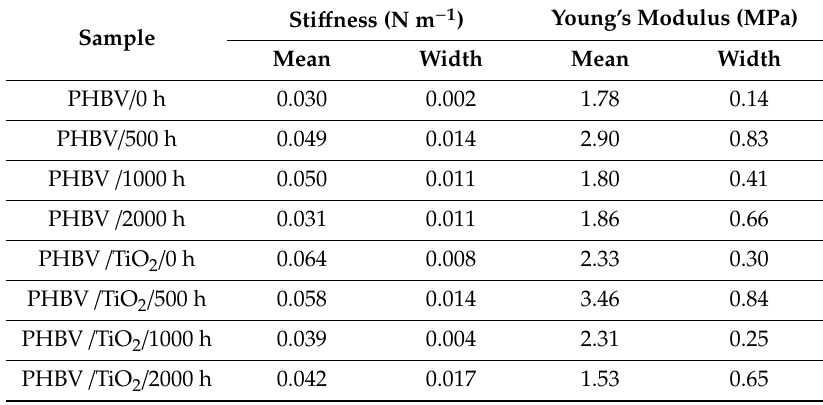
Table 6. Surface mechanical properties of the PHBV and the PHBV / TiO 2 nanocomposites collected from the AFM